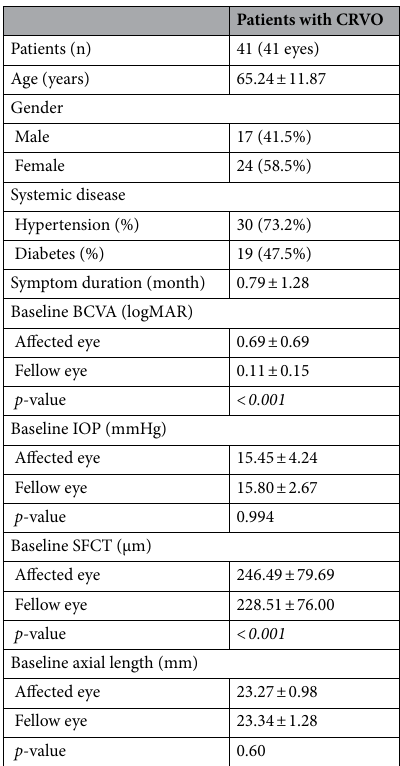
Table 1. Baseline demographics in patients with central retinal vein occlusion (N = 41, 41 eyes). Values are presented as number or mean ± standard deviation, unless otherwise indicated. CRVO central retinal vein occlusion, OD right eye, OS left eye, BCVA best-corrected visual acuity, IOP intraocular pressure, SFCT subfoveal choroidal thickness. p- value derived from the independent t-test for linear values and chi-square test for categorical values. Significant values are in italics.